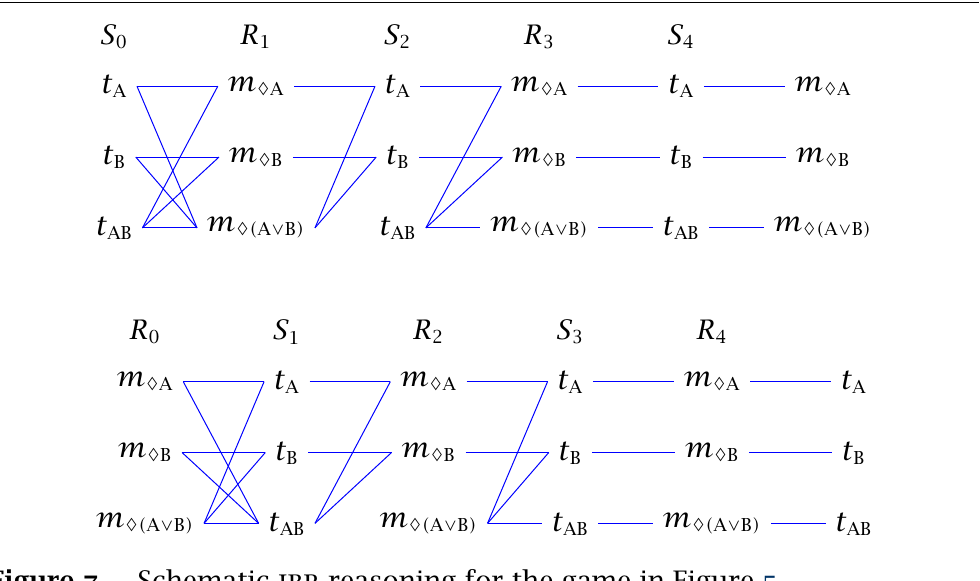
Schematic ibr reasoning for the game in Figure 5